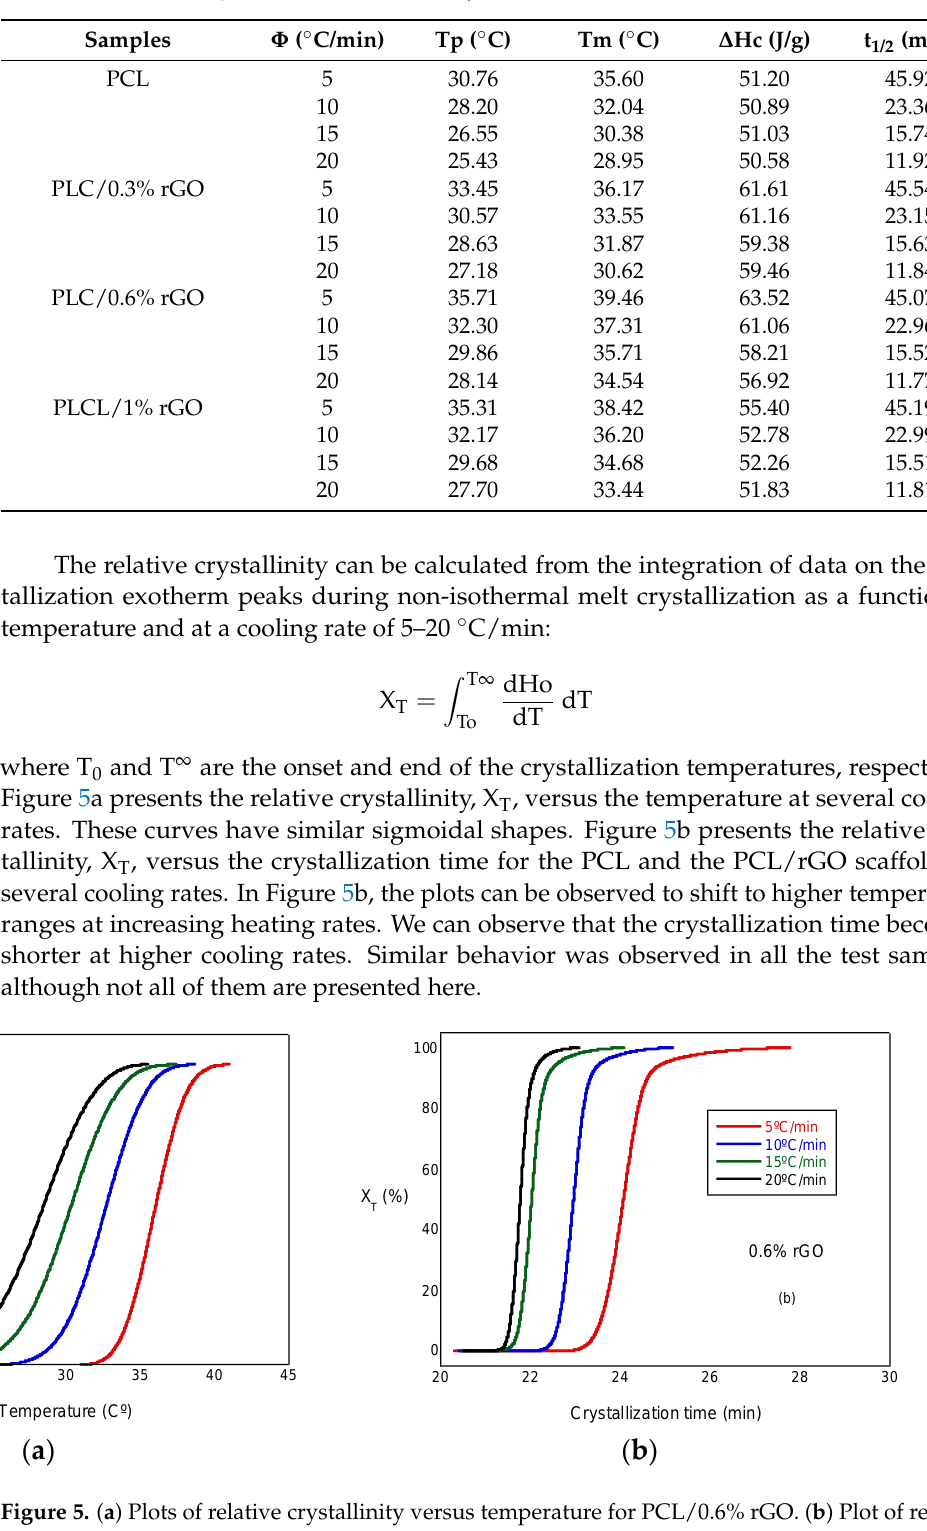
Table 2. Summary of relevant thermal parameters for neat PCL and its nanocomposites: heating rate ( Φ ), non-isothermal peak temperature (Tp), melting temperature (T m ), crystallization enthalpy ( ∆ Hc) and non-isothermal crystallization half-time (t 1/2 ).